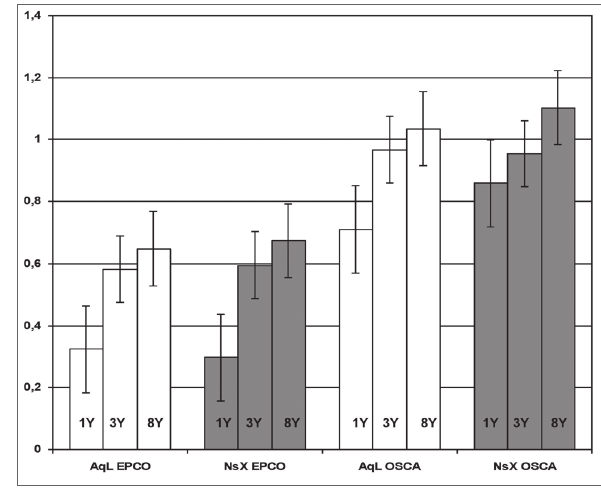
Fig. 1. Summary graph illustrating the development of poste- rior capsule opacification (PCO) after the AquaLase (AqL) and the NeoSoniX (NSX) method for each measurement type, Evaluation of Posterior Capsule Opacification (EPCO) 2000 and Open-Access Systematic Capsule Assessment (OSCA).